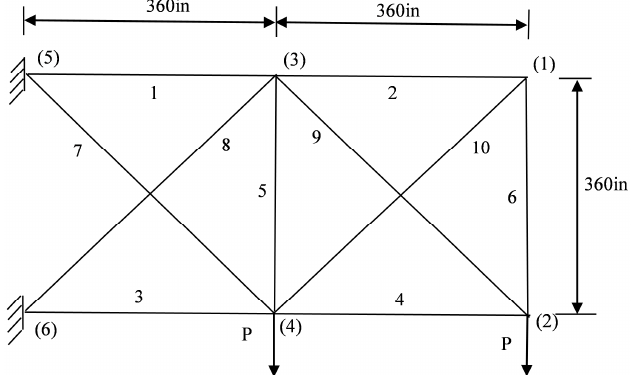
Figure 2. Schematic of the planar 10-bar truss structure.